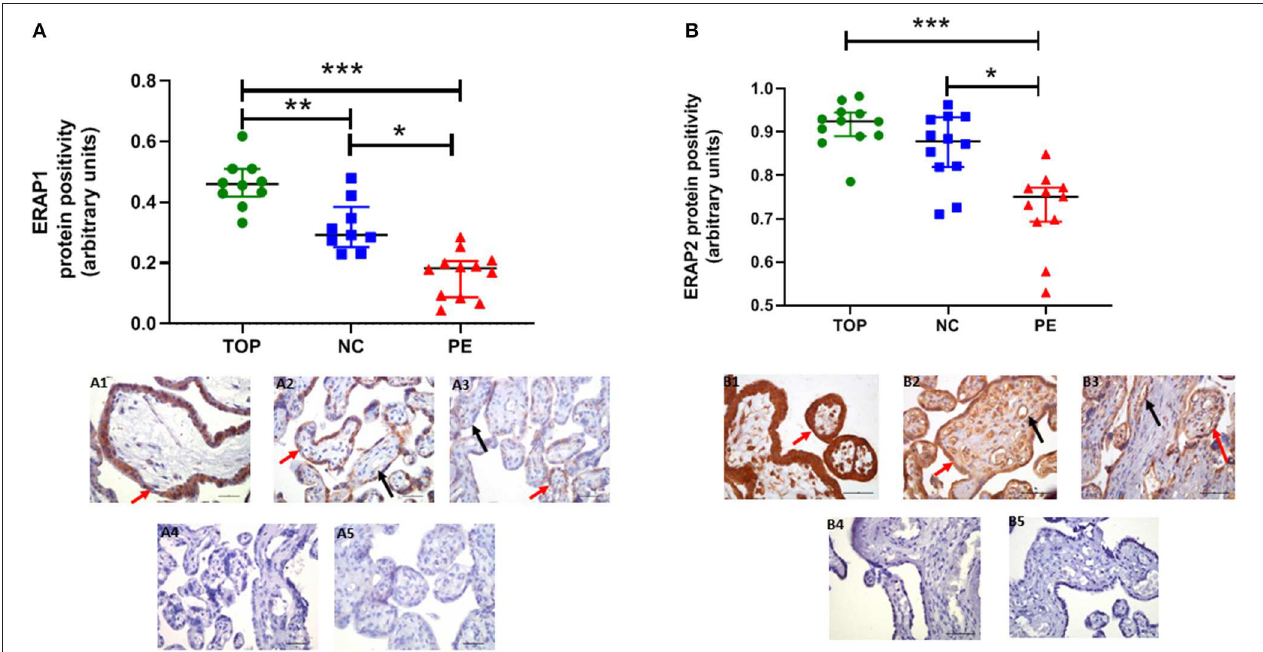
FIGURE 2 | Protein expression assessed by immunohistochemistry. (A) Endoplasmic reticulum aminopeptidase (ERAP)1, (B) ERAP2 in placentae from first trimester (TOP; n = 12), term normotensive controls (NC; n = 12), and women with pre-eclampsia (PE; n = 12). Data are presented as median [interquartile range (IQR)]; * P < 0.05; ** P < 0.01; *** P < 0.0001. Photomicrographs show typical examples of immunostaining in (A1) TOP, (A2) NC, (A3) PE, (A4) IgG negative control, (A5) negative control—no primary antibody. Positive protein expression appears brown and is localized mainly to the syncytiotrophoblast (red arrows) but is also evident around the fetal vessels (black arrows); scale bar = 100 µ m; magnification ×